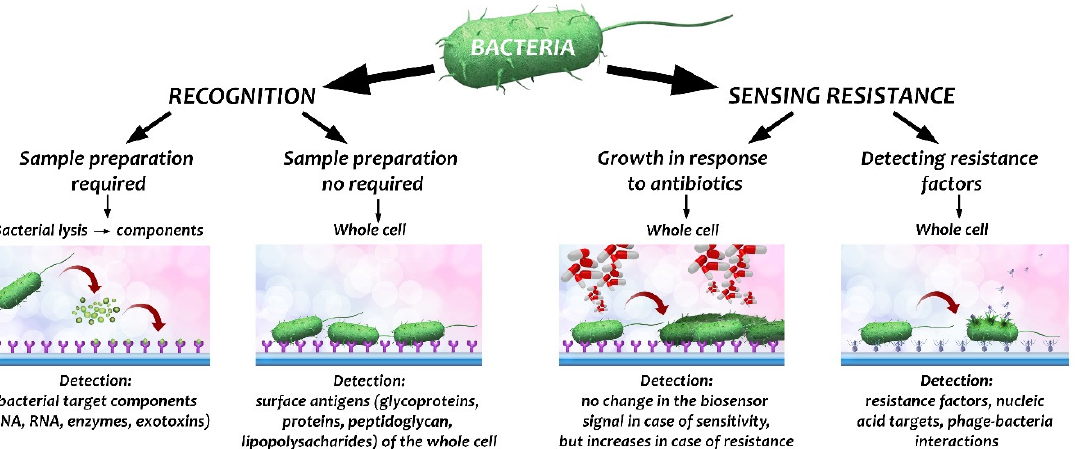
Figure 1. Summary of the strategies of recognition of bacteria and ways of resistance sensing using biosensors. Sample preparation may be needed to lyse the bacteria (or otherwise disrupt them) to liberate the target bacterial components (first column); and preparation-free whole cell-based assays are in the second column. Few biosensors can sense antibiotic resistance as well. There are two possibilities: measuring and monitoring the growth of bacteria during antibiotic treatment (third column) or measuring resistance factor adhesion or bacteriophage–bacterium interaction.